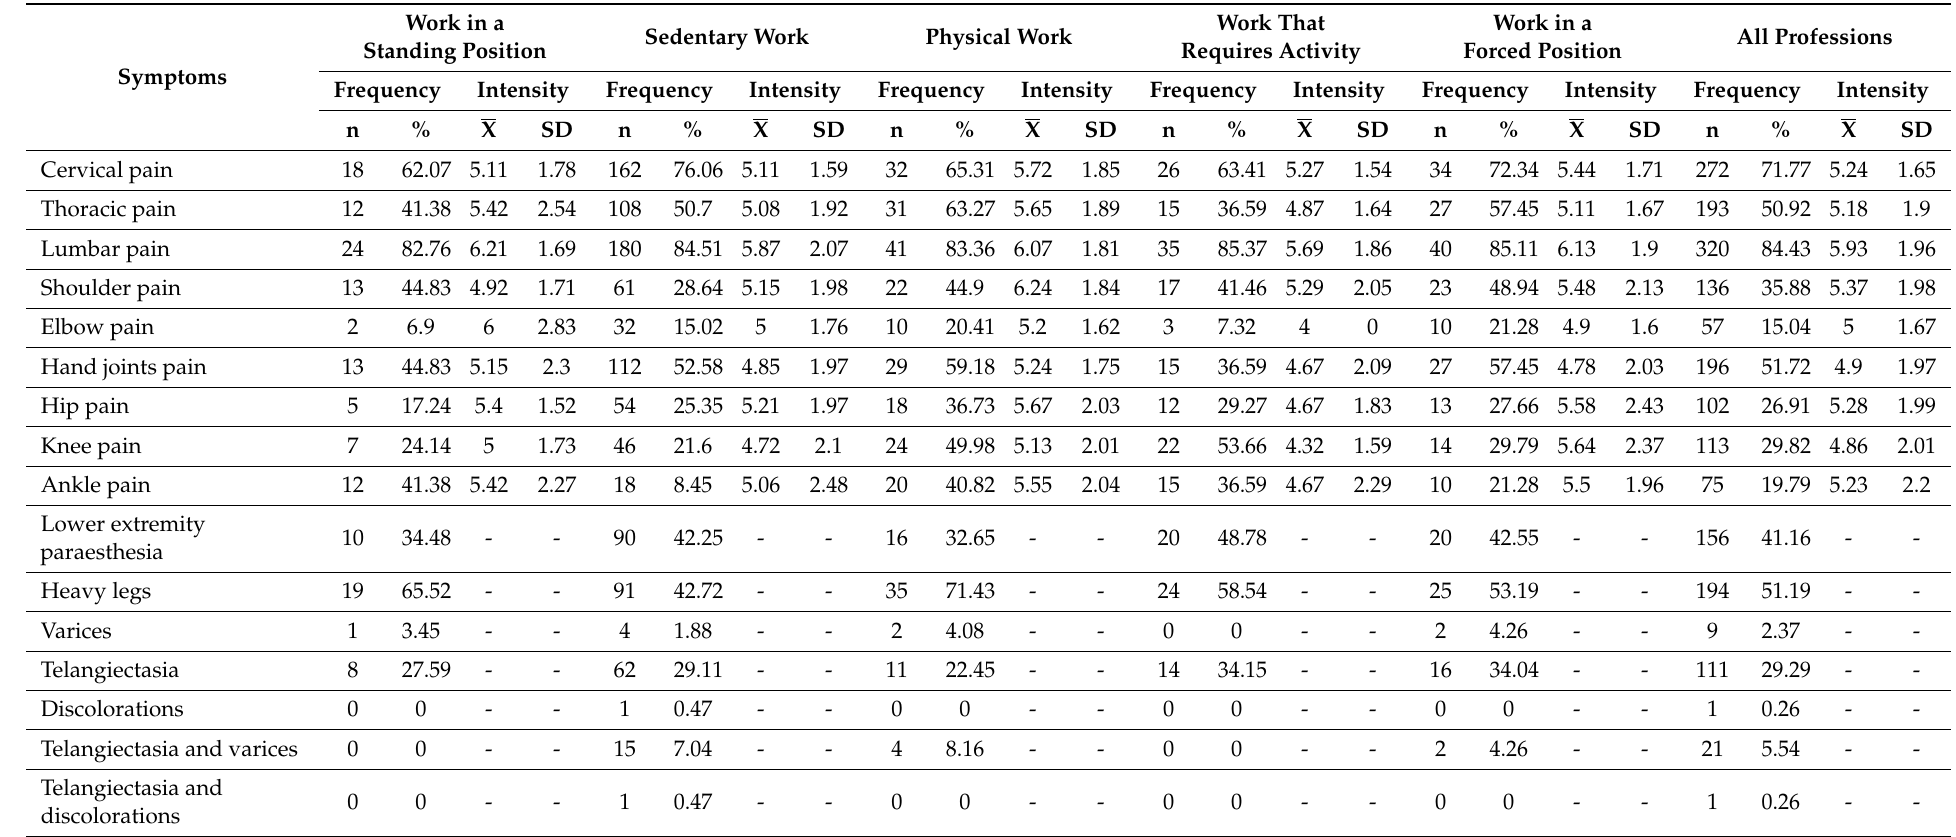
Table 2. Pain frequency and intensity among